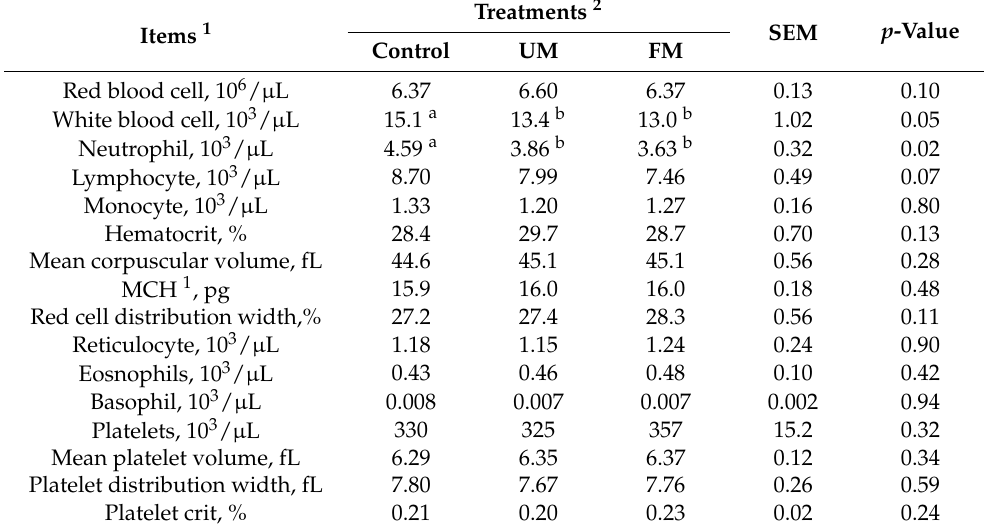
Table 6. Whole blood variables of dairy cows fed the total mixed rations (TMR) containing unfer- mented (UM) and fermented yellow wine lees mix (FM). Items 1